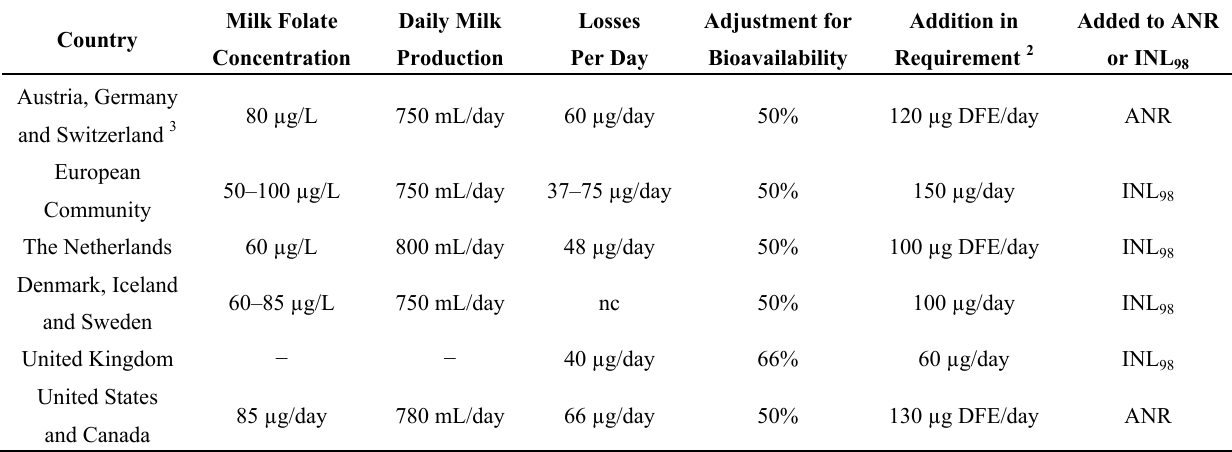
Table 4. Data used to derive nutrient intake values (NIVs) for lactating women from breast-milk losses of folate by country 1